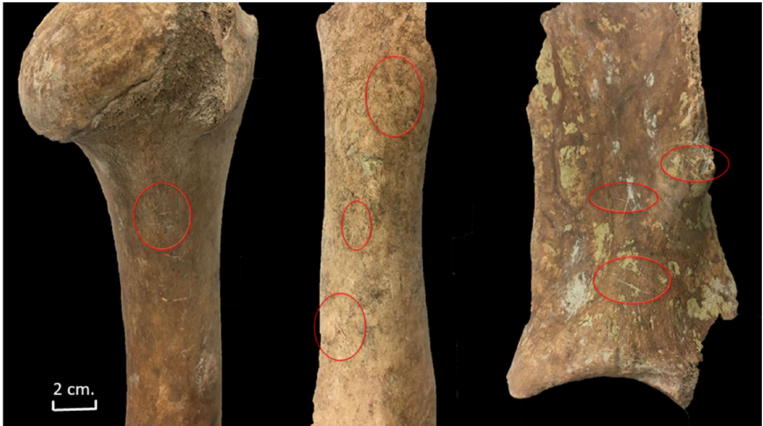
Figure 11. Cut marks documented on a cattle humerus, femur, and scapula from Stratigraphic Unit 1700 of the Vilauba